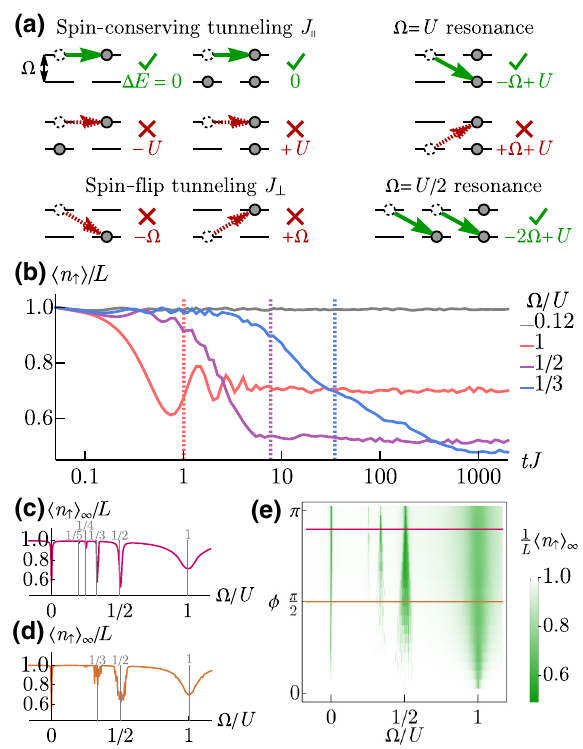
FIG. 3. (a) Diagrams of the allowed and forbidden tunnel- ing processes of the n = 2 system in the diagonal frame for (cid:2) , U (cid:15) J . The energy cost for an atom hopping from one level (indicated by an empty circle) to another (indicated by the arrow) is shown. Processes with green arrows cost zero energy and are allowed, while ones with red arrows are off-resonant and forbid- den. Interaction-enabled tunneling processes are shown for the (cid:2) = U and (cid:2) = U / 2 resonances, although higher-order ones can occur as well. (b) Time evolution of the dressed state popula- tion (cid:12)ˆ n ↑ (cid:4) for a quench starting with all atoms in that state, for a system size L = 11, large flux φ = 9 π/ 10, strong interactions U / J = 30, and selected drive strengths (cid:2)/ U = 0.12 (nonreso- nant) and (cid:2)/ U = 1, 1 / 2, 1 / 3 (different resonances). For the lat- ter, the associated timescales tJ ⊥ = 1, 4 tJ 2 ⊥ / U = 1, 27 tJ 3 ⊥ / U 2 = 1 are indicated by vertical dotted lines. (c),(d) Long-time average of the population (cid:12)ˆ n ↑ (cid:4) ∞ with U / J = 30, system size L = 9, and flux values of (c) φ = 9 π/ 10 and (d) φ = π/ 2, averaging out to time tJ = 500. Discernable resonances (cid:2) = U / q are labeled. (e) Average population across the parameter range of (cid:2)/ U and φ , still using U / J = 30 and L = 9. The colored lines correspond to panels (c) and